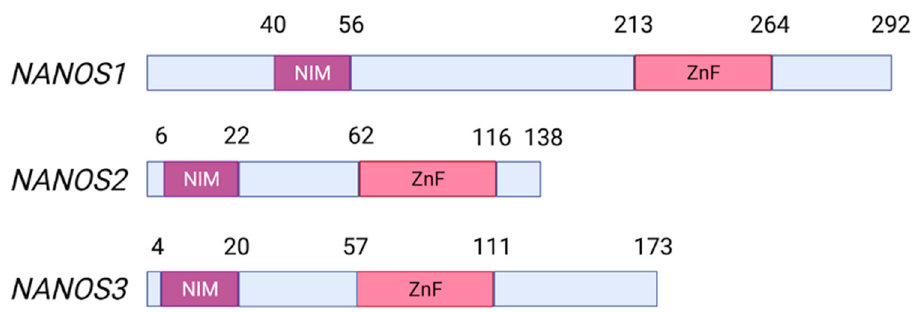
Figure 1. Schematic representation of human NANOS genes showing functional Not1 Interacting Motif (NIM) and (CHCC)2 zinc finger (ZnF) domains. Created with Biorender.com (accessed on 15 July 2022).